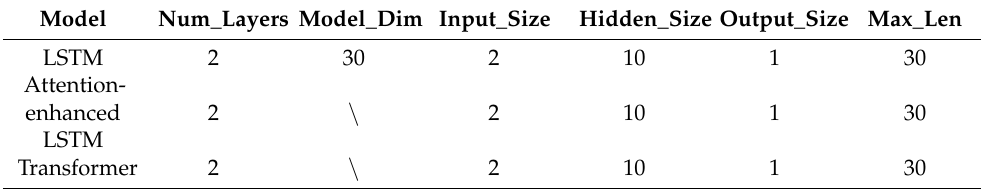
Figure 11. The training and validation loss curves of the transformer model. Table 3. The model structures of different deep learning